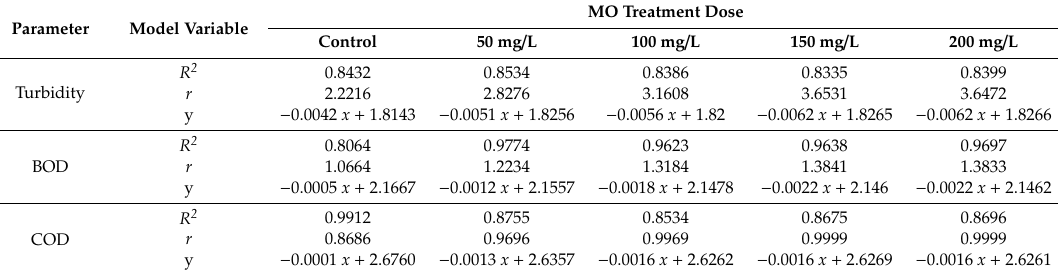
Table 2. First-order kinetic variables for percent turbidity, BOD, and COD removal.